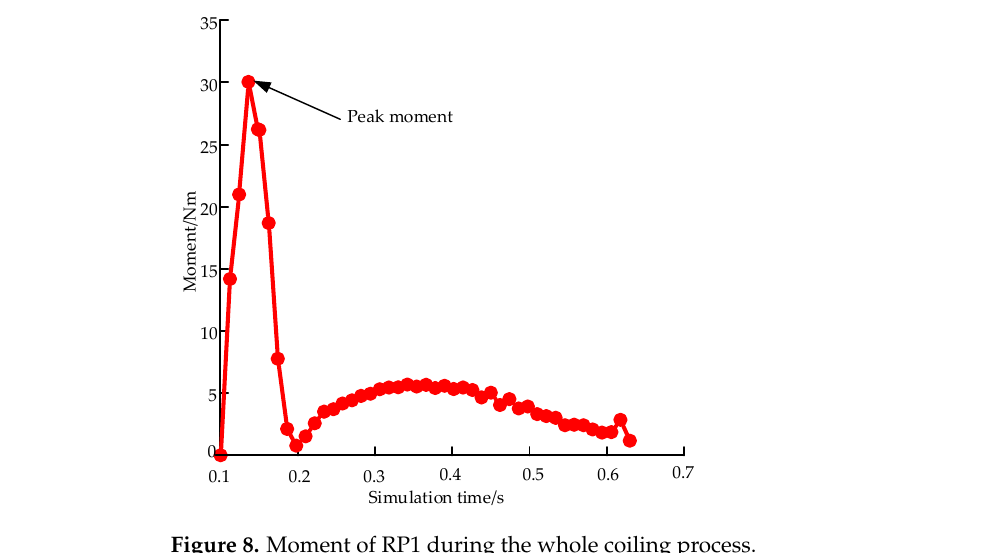
Figure 8. Moment of RP1 during the whole coiling process.